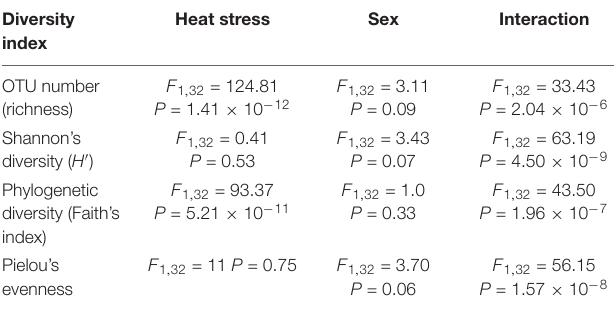
TABLE 2 | Results of the analysis of variance of the effects of heat stress (non-stressed and heat-stressed flies), sex (female and male flies), and its interaction on the bacterial diversity indices associated with the gut microbiota of Drosophila subobscura